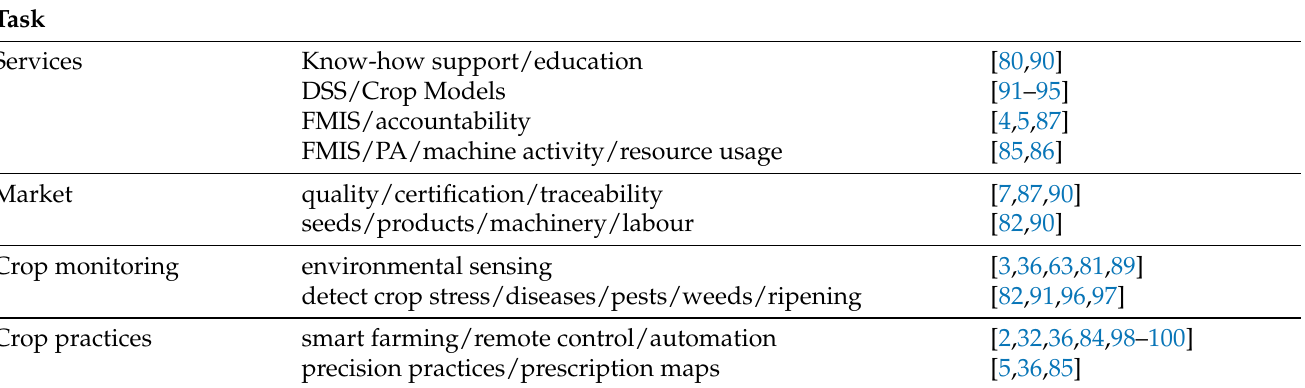
Table 4. Major activities involving IoT